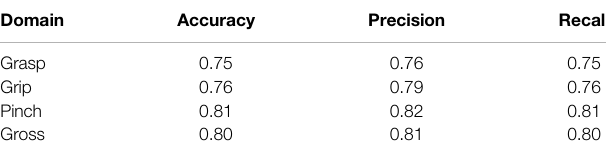
TABLE1| OverviewofperformanceofthemodelpredictingtheARATtaskscores in the four domains: weighted accuracy, precision, and recall.